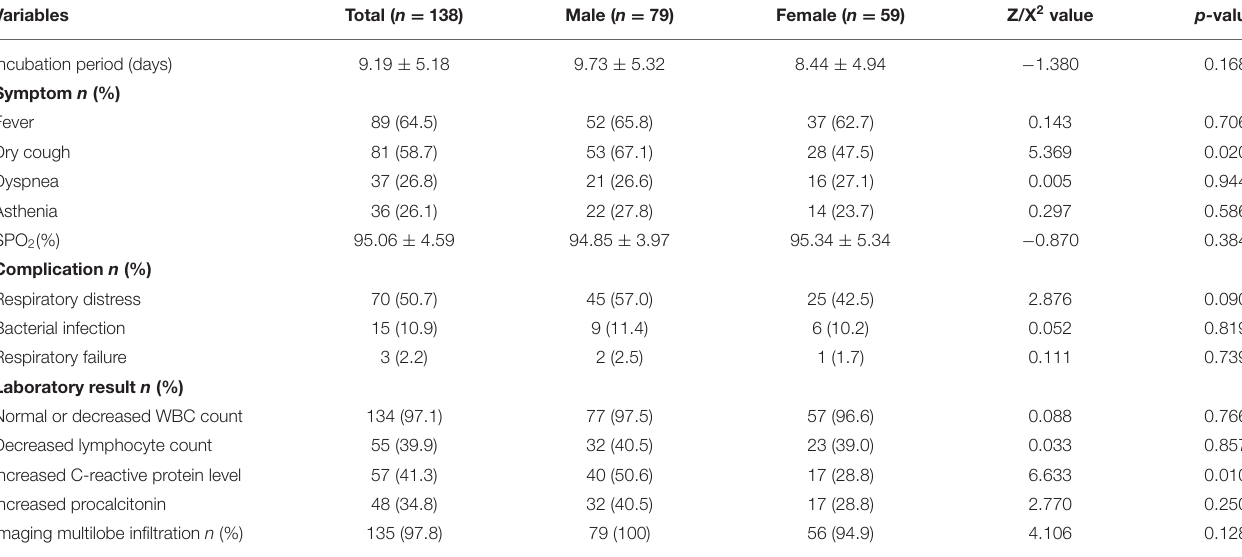
TABLE 2 | Gender differences in clinical characteristics of 2019-nCoV